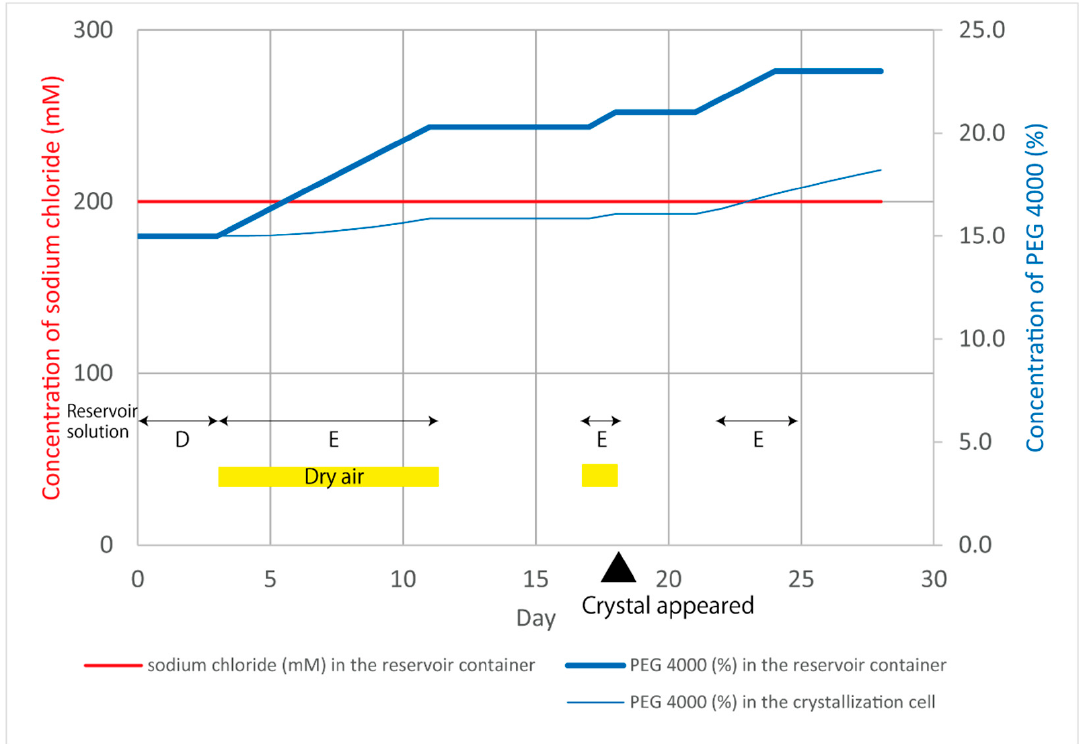
Figure 4. Controlling alpha-amylase crystallization conditions by changing the reservoir solution. The concentration of PEG 4000 in the reservoir container and the estimated concentration of PEG 4000 in the crystallization cell are shown as thick blue lines and thin blue lines, respectively. The concentration of sodium chloride (red line) was fixed during the experiment. The reservoir solution flowing to the reservoir container was changed as indicated by the black double arrows: D, 15% ( w / v ) PEG 4000 at a flow rate of 240 µ L/min; E, 45% ( w / v ) PEG 4000 at a flow rate of 0.14 µ L/min. All solutions were dissolved in 50 mM HEPES buffer pH 7.0 containing 200 mM sodium chloride and 2 mM calcium chloride. Dry air was supplied at a flow rate of 0.5 mL/min during the first and second flows of Reservoir E.